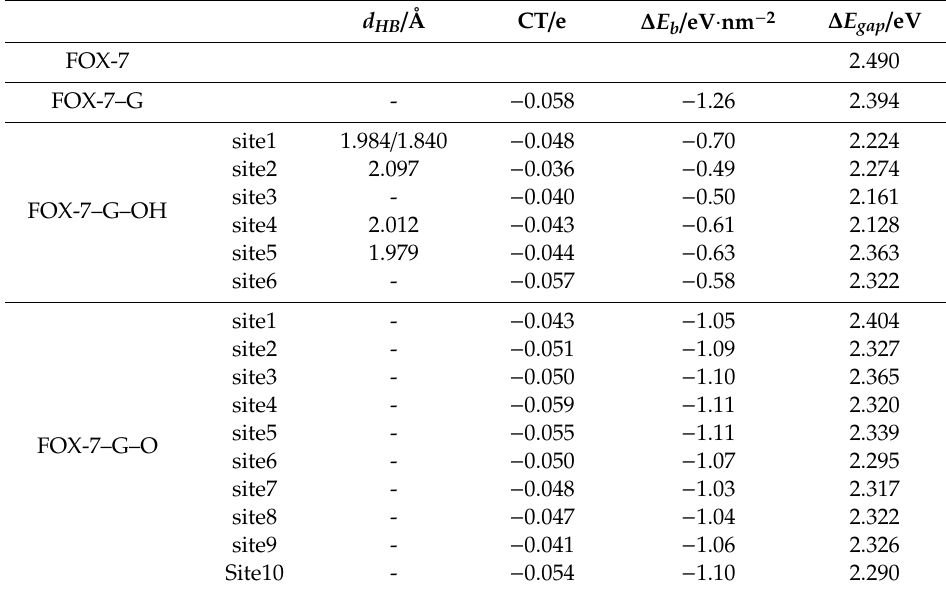
Table 1. The interfacial hydrogen bond length ( d HB ), charge transfer from GO to FOX-7 monolayer (CT), binding energies ( ∆ E b ), and band gaps ( ∆ E gap ) of the FOX-7 monolayer in composite. d HB / Å CT / e ∆ E b / eV · nm − 2 ∆ E gap / eV